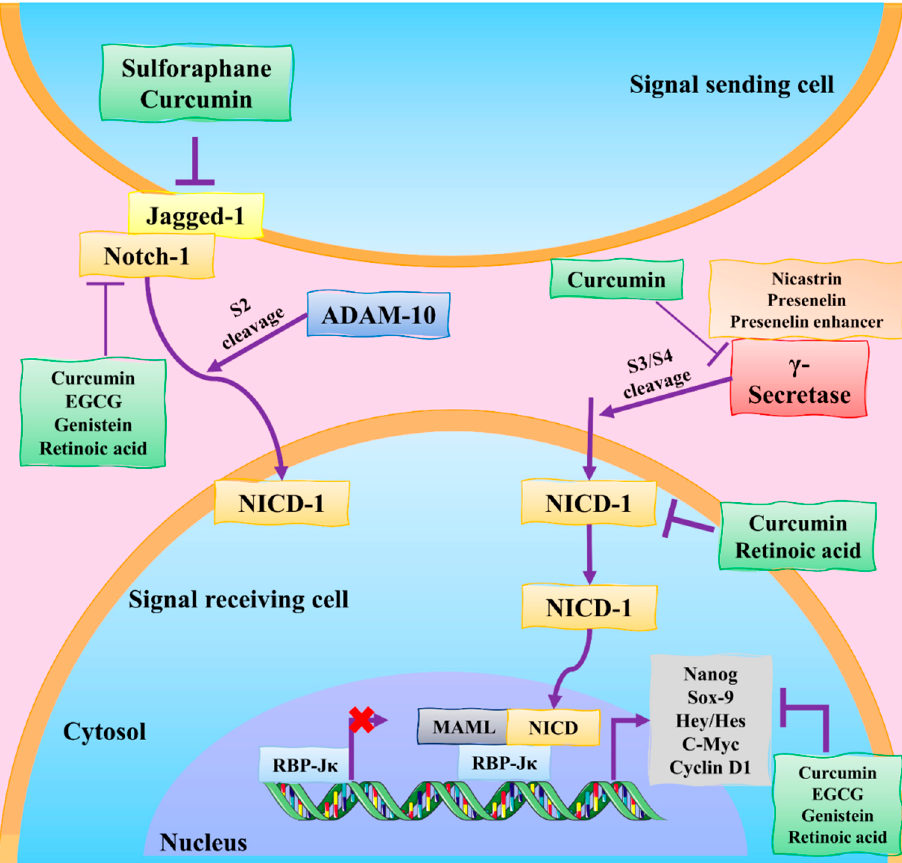
Figure 6. Natural products regulate the modulation of the Notch signaling pathway in BC. The Notch receptor is cleaved by Notch ligands, including Jagged-1. ADAM-10 initially cleaves the Notch extracellular domain; the gamma–secretase complex then cleaves the Notch intracellular domain (NICD). NICD moves into the nucleus and initiates transcription. MAML: mastermind-like protein; EGCG: epigallocatechin-3-gallate; RBP-J κ : recombinant signal binding protein for immunoglobulin kappa J region; DATS: diallyl trisulfide; ADAM-10: a disintegrin and metalloproteinase domain-containing protein 10; NICD: Notch receptor intracellular domain. This figure is reproduced from Kiesel et al. [87] (Creative Commons Attribution License (CC BY 4.0)).